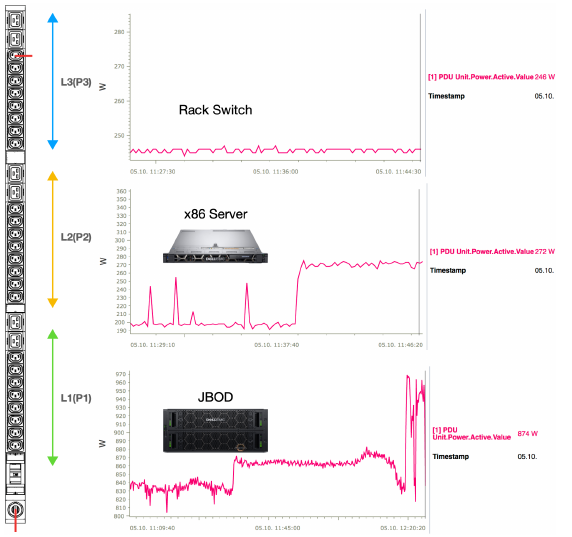
Figure 5. The electrical power consumption in idle status and full load measured during read / write tests. In this configuration, only one network switch, one x86_64 front-end server and one JBOD enclosure are placed in a